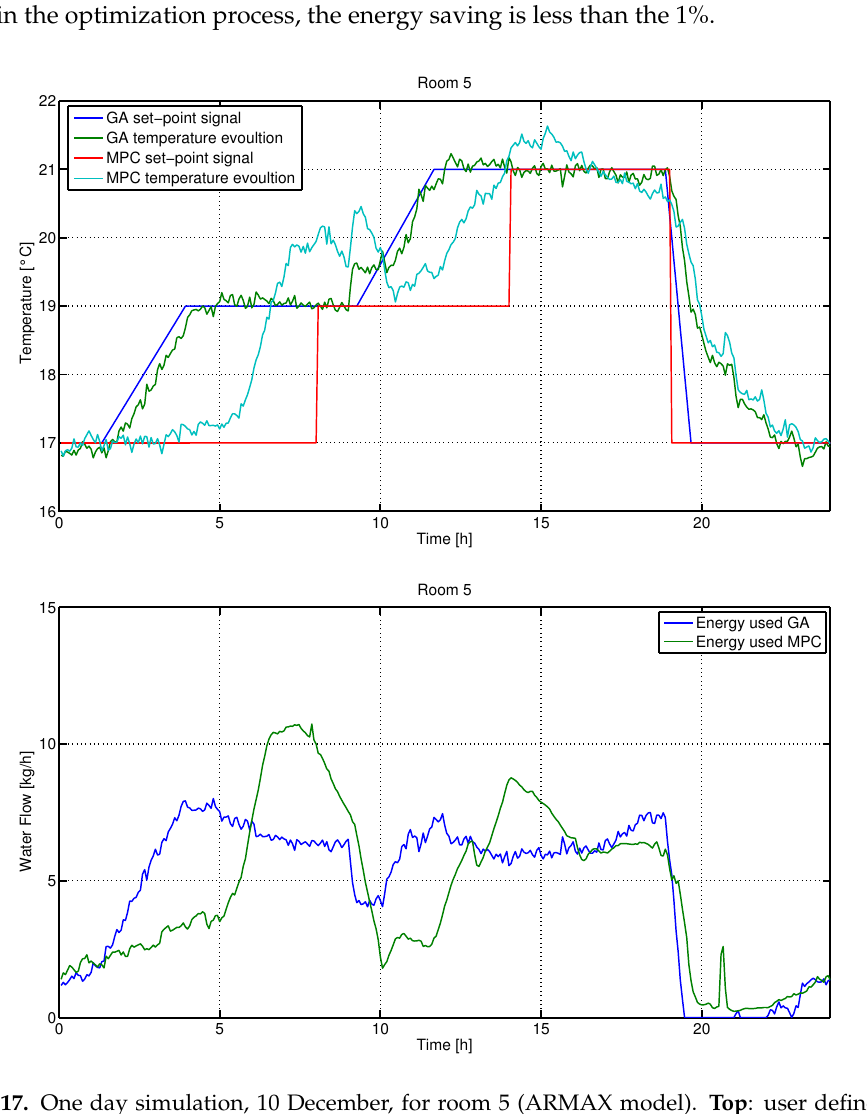
Figure 17. One day simulation, 10 December, for room 5 (ARMAX model). Top : user defined set point ˜ T i (red line), optimized set-point ramp signal ¯ T i (blue line), temperature evolution T i in case of genetic algorithm set-point signal (green line), temperature evolution T i in case of MPC (light blue line). Bottom : resulting inlet water flow in case of ramp set-point signal (blue line) and in case of Model Predictive Control (MPC) (green